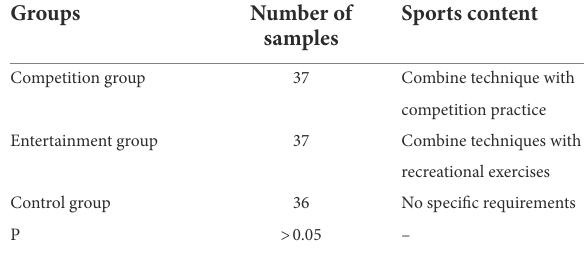
TABLE 2 Grouping table.